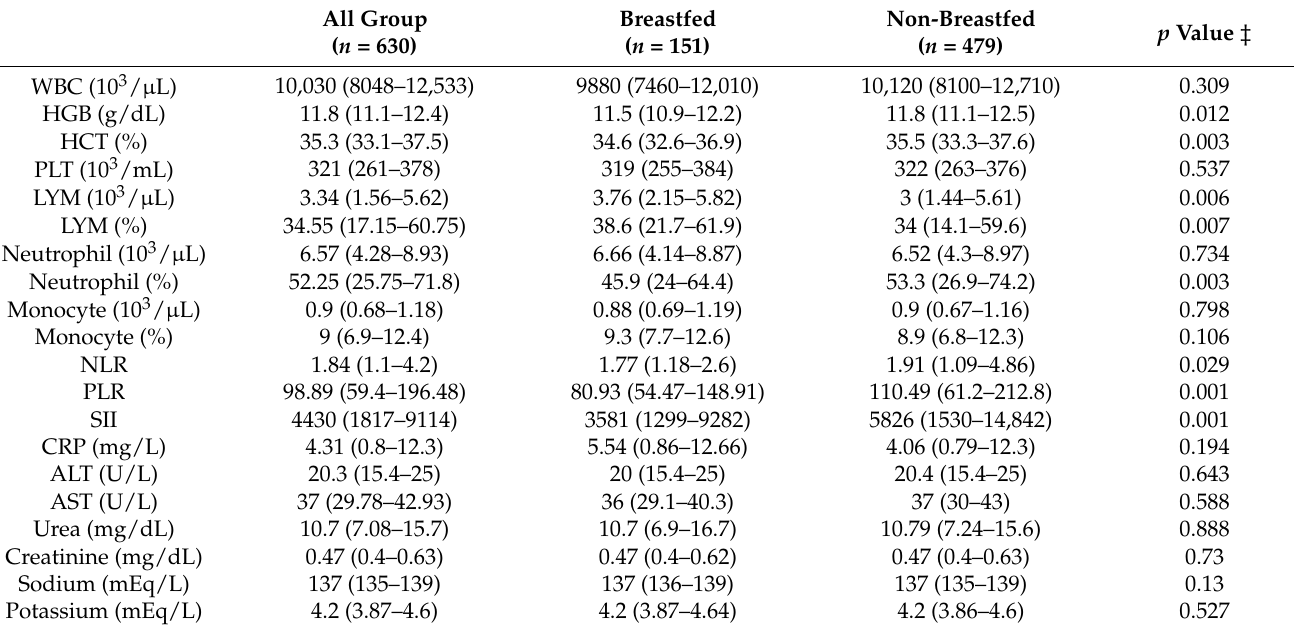
Table 3. Laboratory findings of breastfed and non-breastfed children with rotavirus infections.